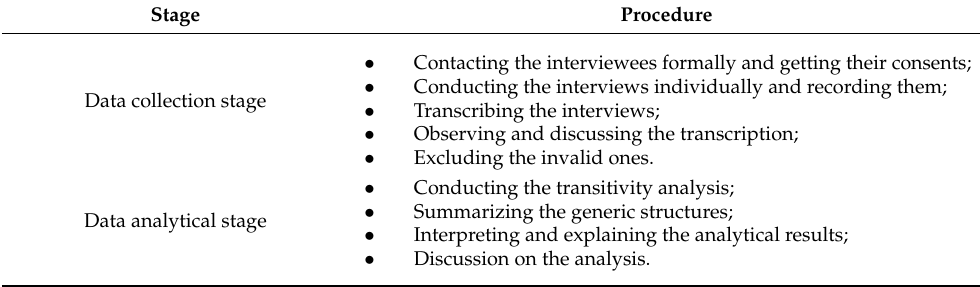
Table 2. Procedures for the